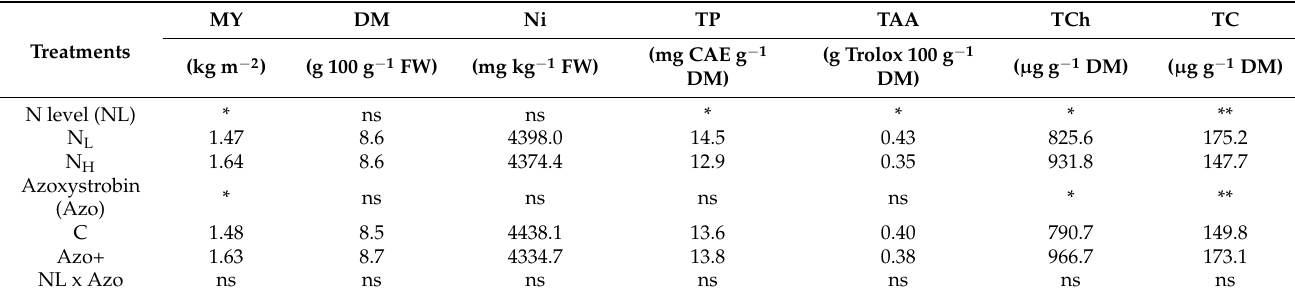
Table 1. Effects of N level (NL) and Azoxystrobin (Azo) application on marketable yield (MY), leaf dry matter (DM), nitrate (Ni), total phenols (TP), total antioxidant activity (TAA), total chlorophyll (TCh) and total carotenoids (TC) of wild rocked at harvest time. C = control without Azoxystrobin, Azo+ = with Azoxystrobin; N L = 24 kg ha − 1 of N, N H = 84 kg ha − 1 of N; FW = fresh